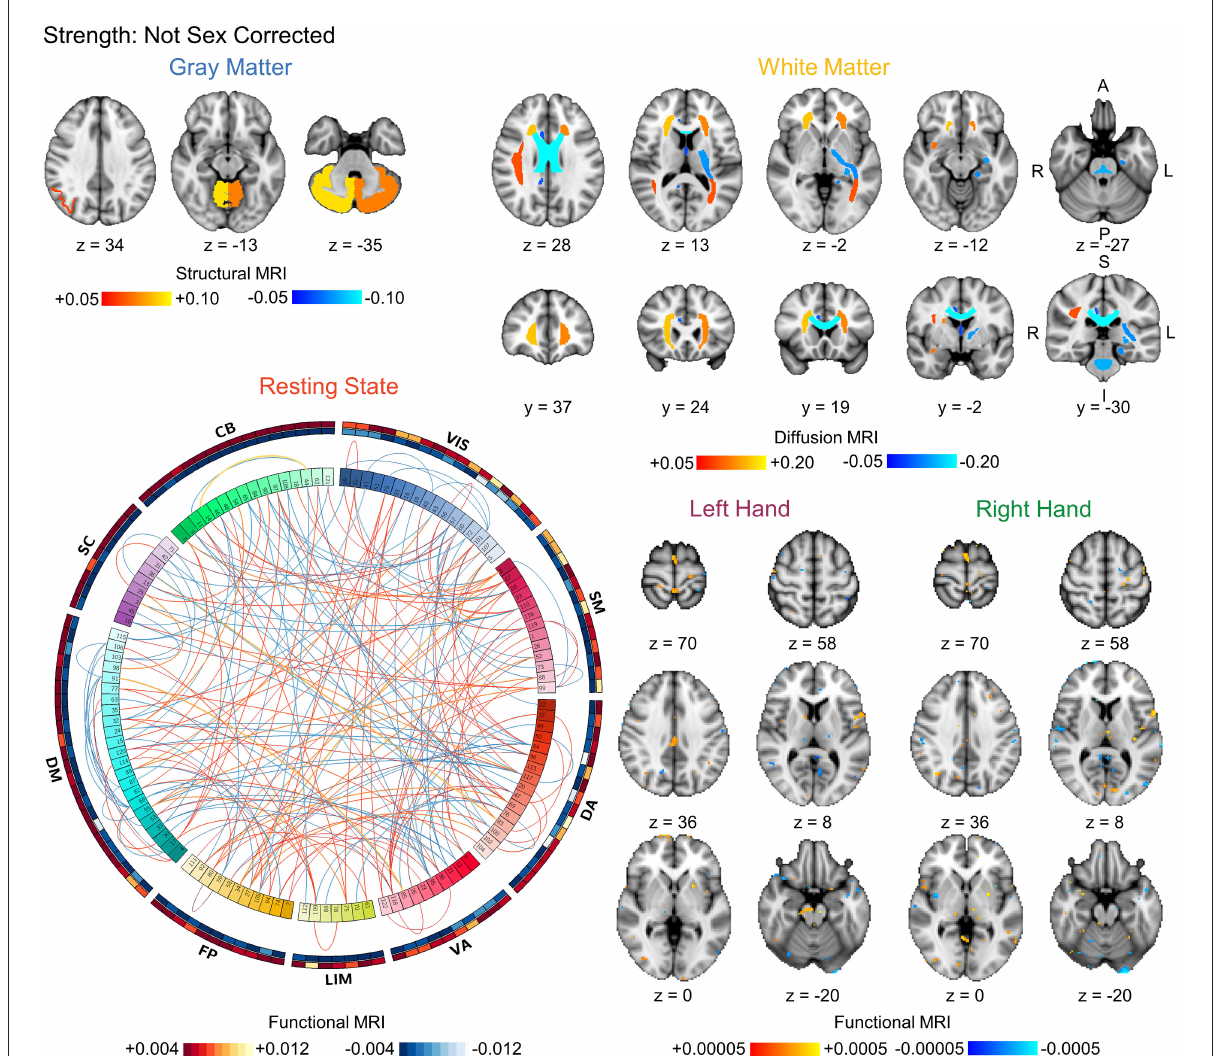
FIGURE3 Visualization of the bootstrapped FDR-corrected ( q < 0.05) first-level model coefficients of each MRI modality for strength prediction without correction for sex. Note the similarity between these models and the sex prediction models without correction for strength shown in Figure 4. The outer bands in the resting state connectivity graph show the sum of the positive and negative connections passing FDR-correction. VIS, visual; SM, somatomotor; DA, dorsal attention; VA, ventral attention; LIM, limbic; FP, frontoparietal; DM, default mode; SC, subcortical; CB, cerebellar. L, left; R, right; A, anterior; P, posterior; S, superior; I,